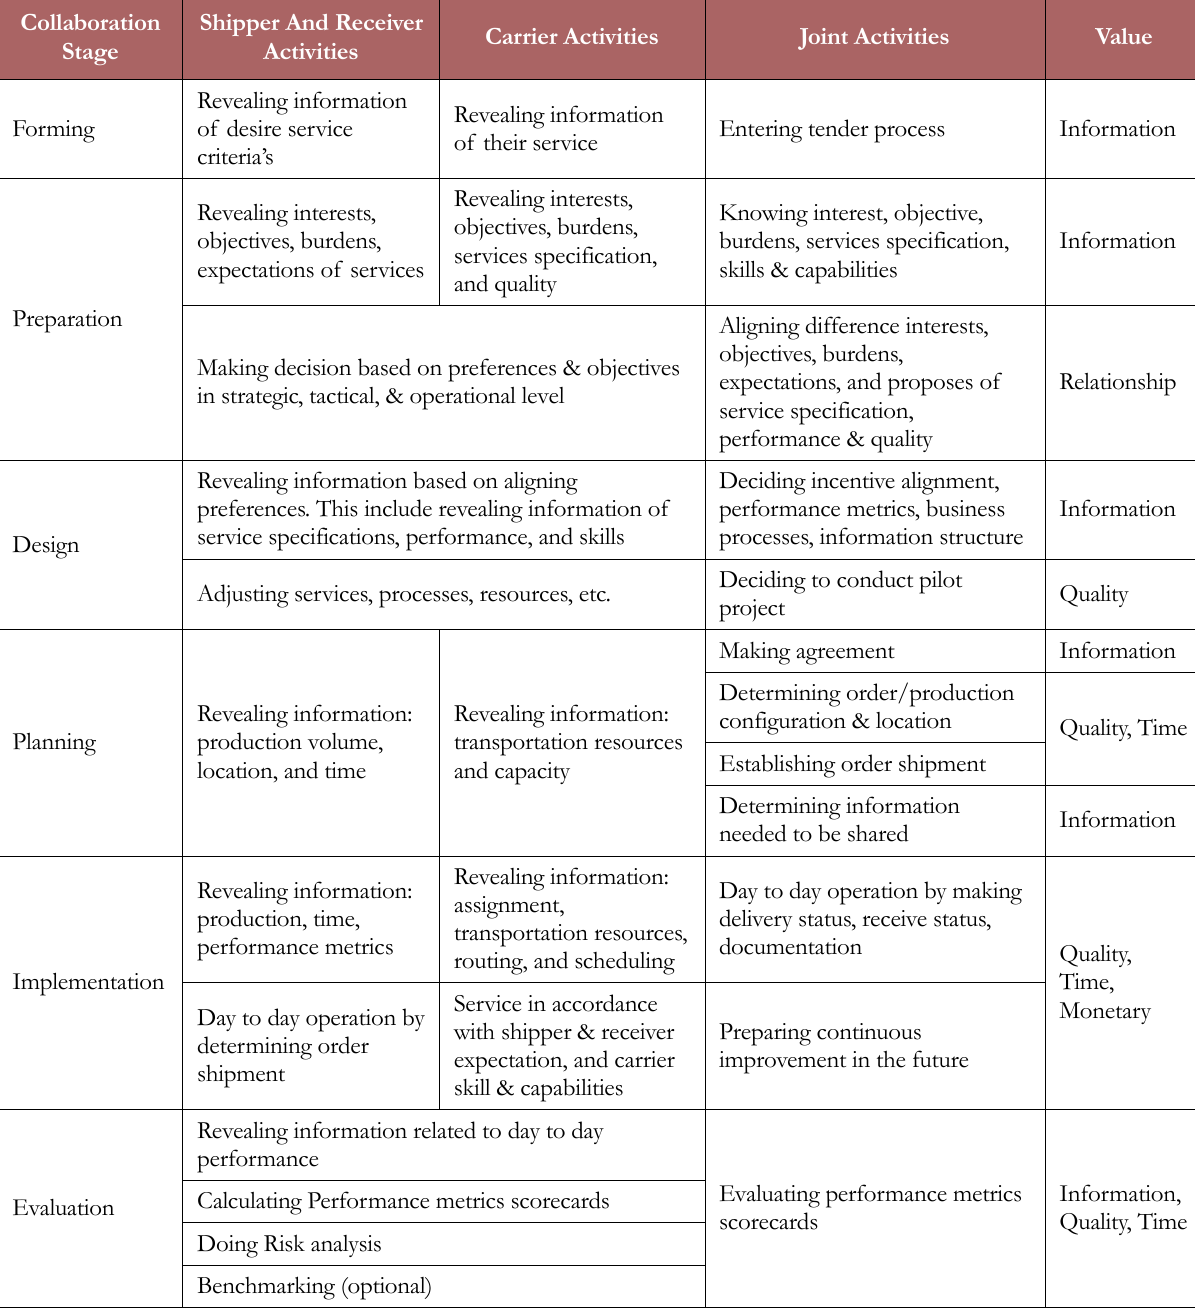
Table 1. Value Co-creation and Activities of